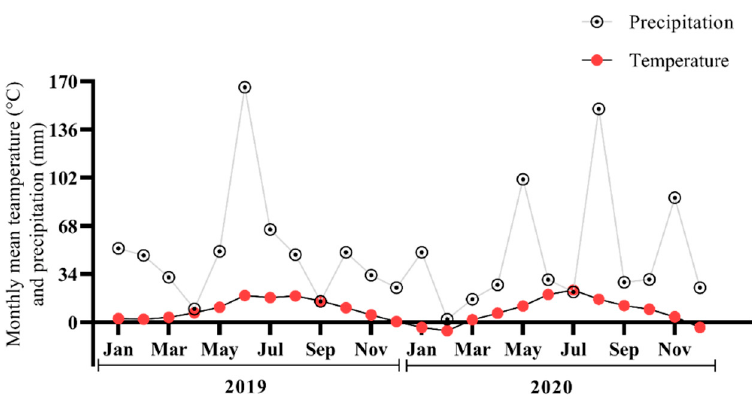
Figure 1. Monthly mean temperature and precipitation at the experimental site during the period